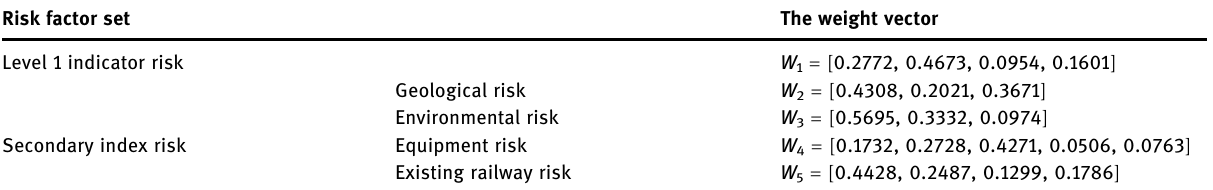
Table 1: Weight vector calculated values of risk factor sets Risk factor set The weight vector Level 1 indicator risk